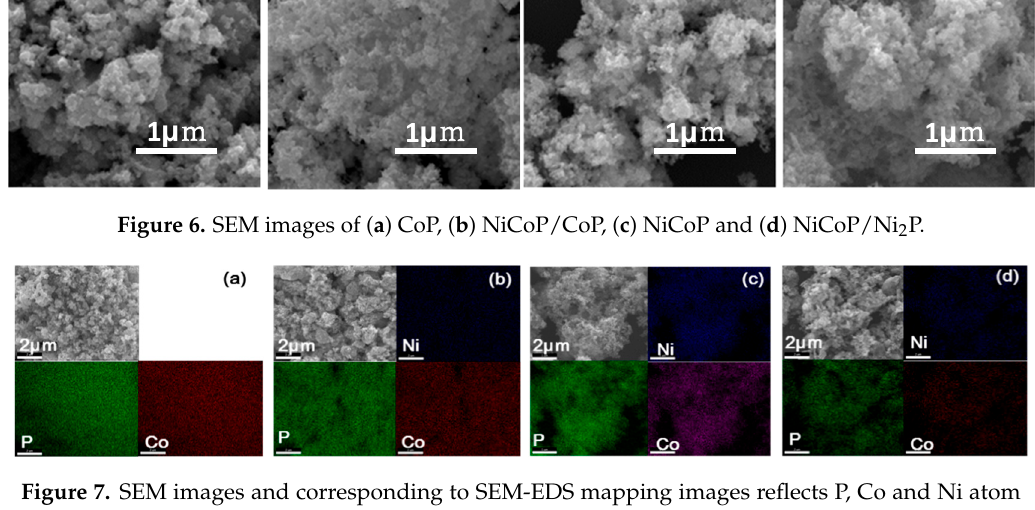
Figure 7. SEM images and corresponding to SEM-EDS mapping images reflects P, Co and Ni atom distributions for the ( a ) CoP, ( b ) NiCoP/CoP, ( c ) NiCoP and ( d ) NiCoP/Ni 2 P.